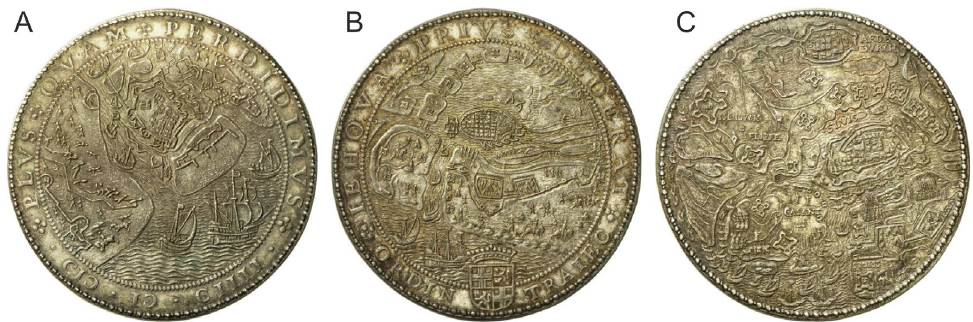
Fig. 1. Medals commemorating the capture of Ostende and Sluis in 1604 during the Eighty Years’